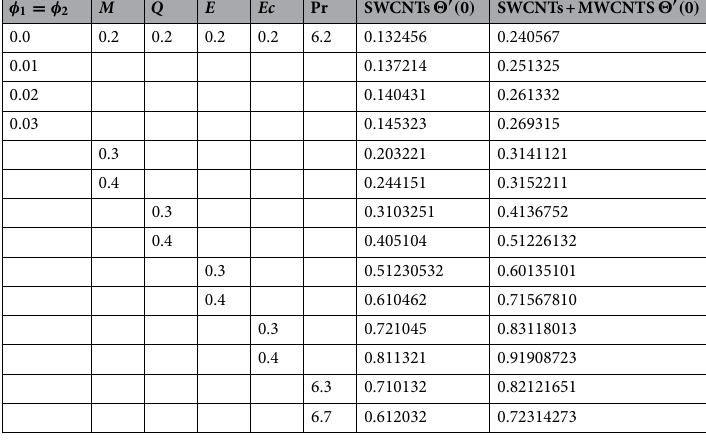
Table 2. � ′ ( 0 ) versus various parameters for the blood base hybrid nanofluid.